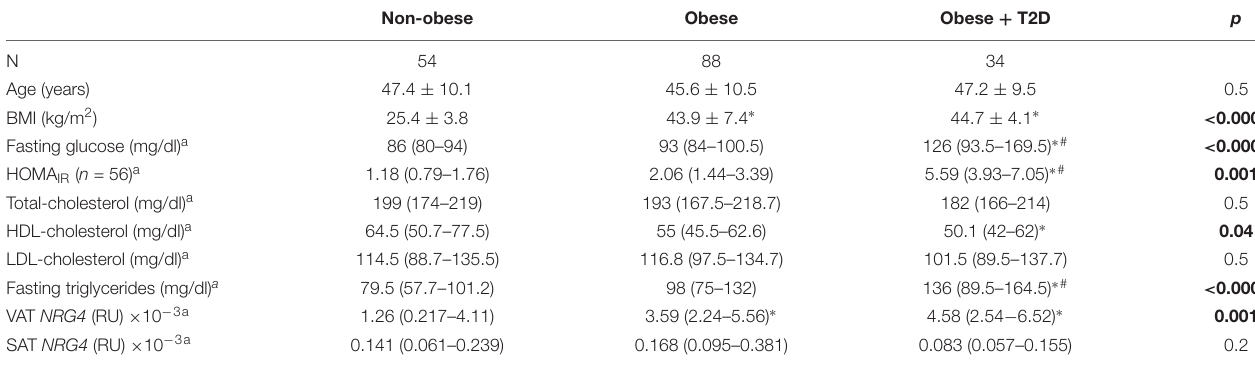
TABLE 2 | Anthropometric and clinical characteristics according to obesity and T2D in cohort 1. Non-obese Obese Obese +